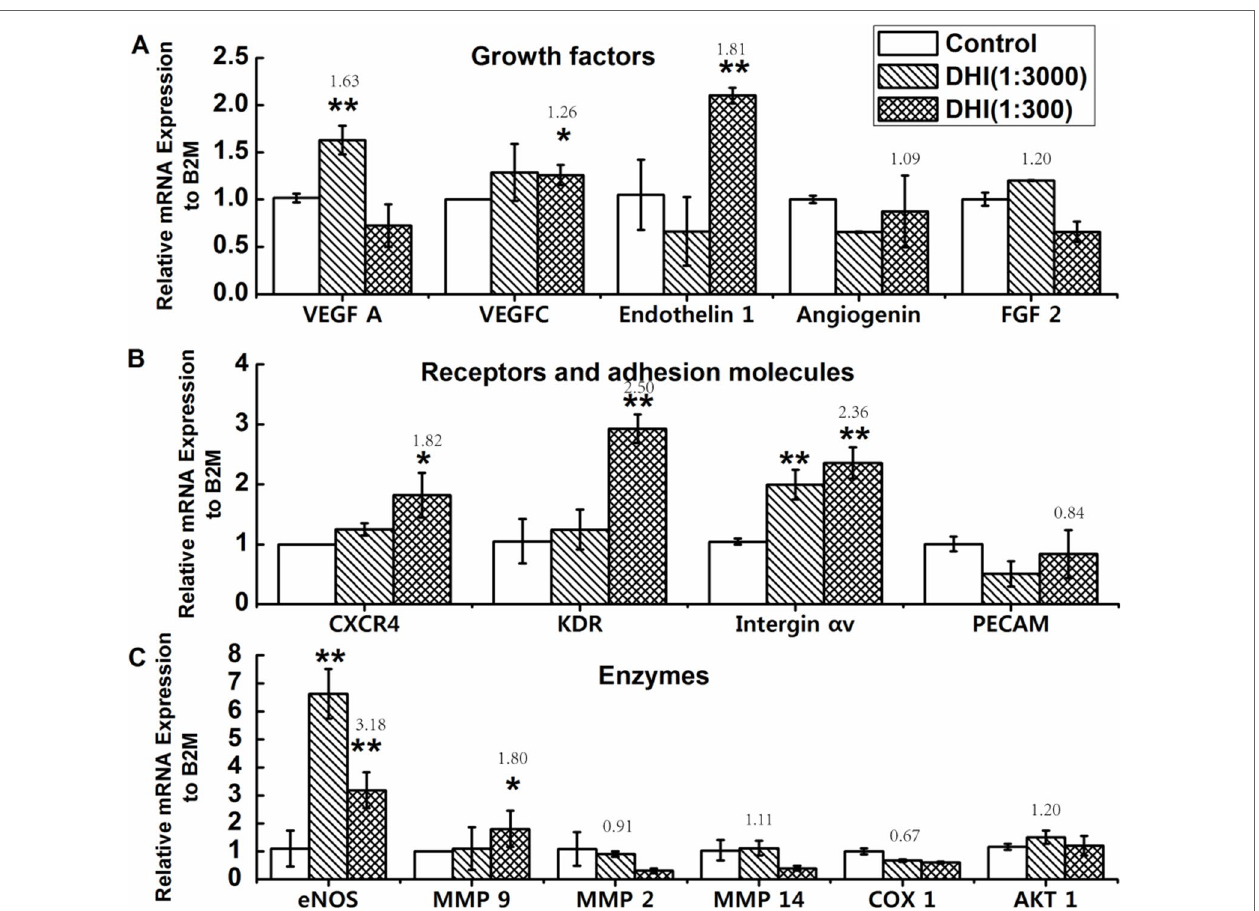
FIGURE 5 | Effects of DHI on the expression of angiogenesis related genes in EPCs. EPCs were treated with DHI (3000 and 300, dilution folds) for 24 h, then qPCR assay was performed. (A) Quantitative PCR showing increased expression of VEGFA, VEGFC, and Endothelin 1 in EPCs treated with DHI. (B) Quantitative PCR showing increased expression of CXCR4, KDR, and Integrin α v in EPCs treated with DHI. (C) Quantitative PCR showing increased expression of eNOS and MMP9 in EPCs treated with DHI. *P < 0.05, **P < 0.01 vs. control group. Data represent the mean ± SD. All experiments were performed in duplicate and confirmed the